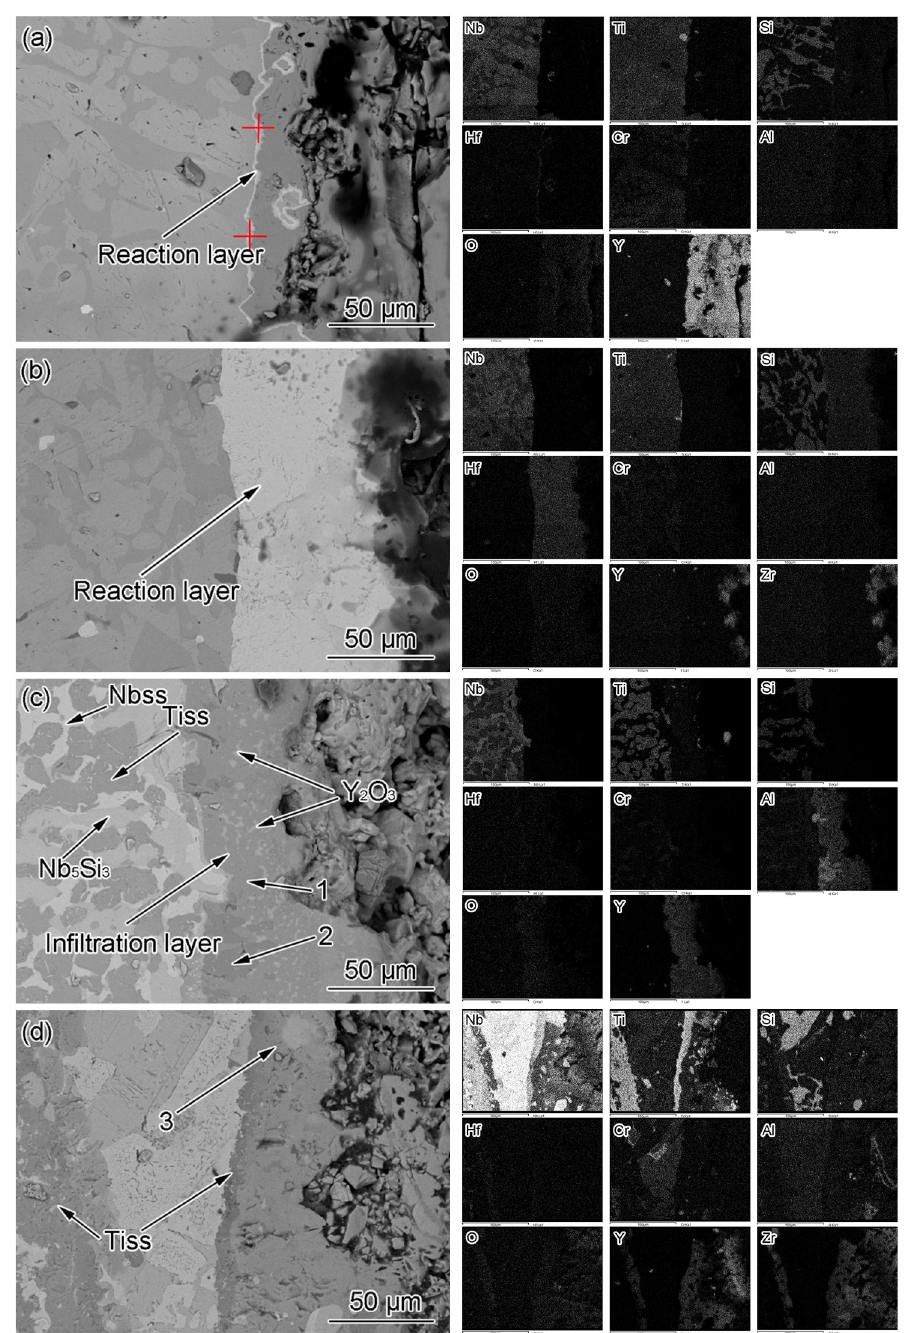
Figure 9. Morphologies of the interfaces between the alloy and the mold shells in: ( a ) Y and ( b ) Z samples after re-melting in a vacuum furnace with a tungsten heating element and ( c ) Y and ( d ) Z samples after re-melting in a vacuum furnace with a graphite heating element.